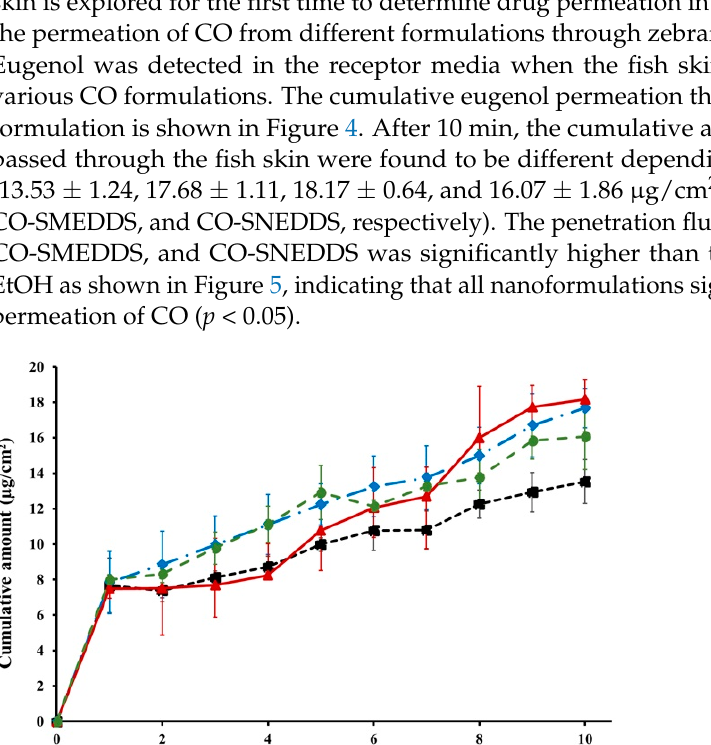
Figure 3. Relative fluorescent intensity of CONR nanoformulations. Asterisk (*) indicates a significant difference compared to CONR-EtOH ( p < 0.05).